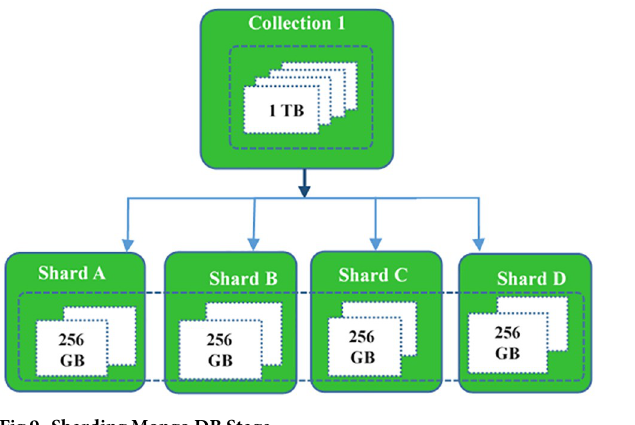
Fig 9. Sharding Mongo DB Stage.